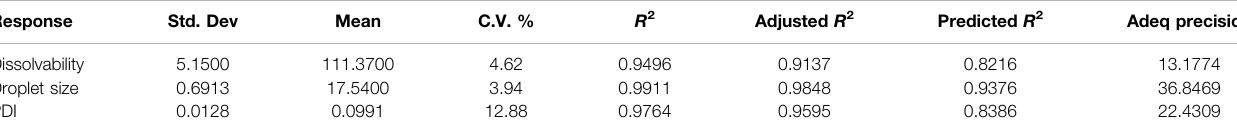
TABLE 6 | Model fi t summary and analysis of variance (ANOVA) for dependent